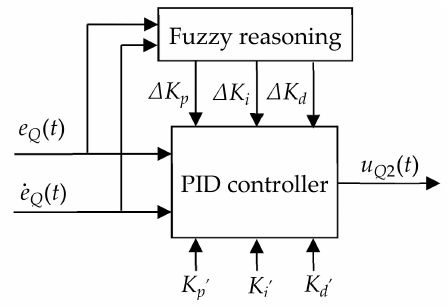
Figure 3. Diagram of the adaptive fuzzy nonlinear PID controller. Note: K p (cid:48) is the initial value of proportional gain; K i (cid:48) is the integral initial value; K d (cid:48) is the di ff erential initial